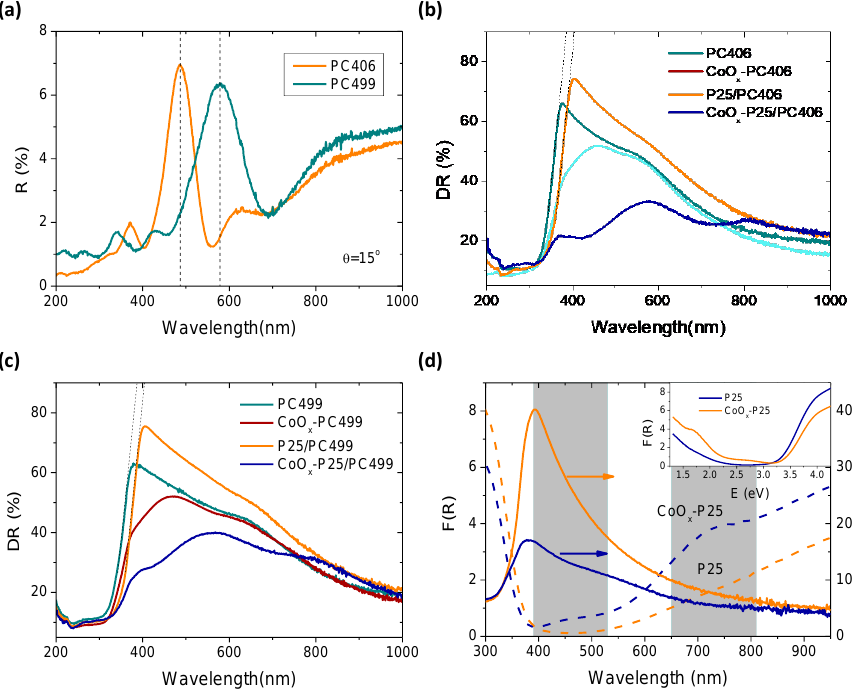
Figure 5. ( a ) Specular reflectance (R%) spectra for the PC406 and PC499 films. Diffuse (DR%) reflectance spectra for the pristine and CoO x -modified single- and bilayer films supported on the ( b ) PC406 and ( c ) PC499 inverse opals. ( d ) The DR% and the corresponding Kubelka–Munk absorbance spectra for the P25 and CoO x -P25 films. The inset shows the corresponding F(R) spectrum in eV.